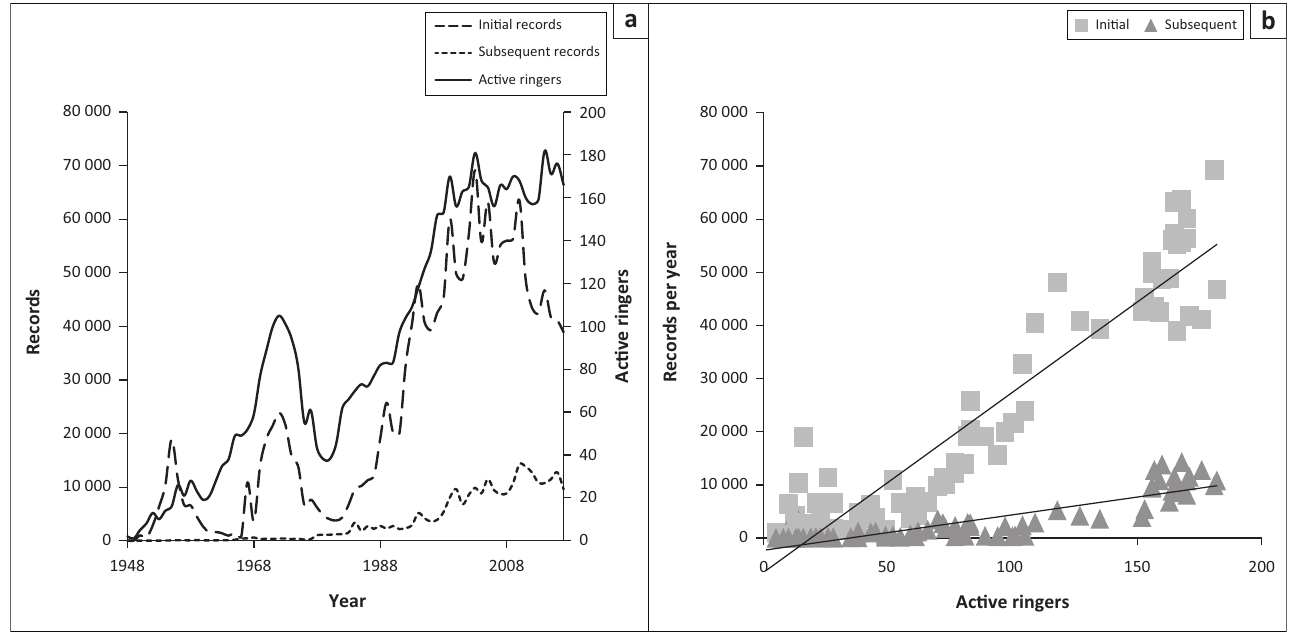
FIGURE 2: (a) Number of active ringers and Passeriformes records per year and (b) the number of active ringers compared to initial and subsequent records per